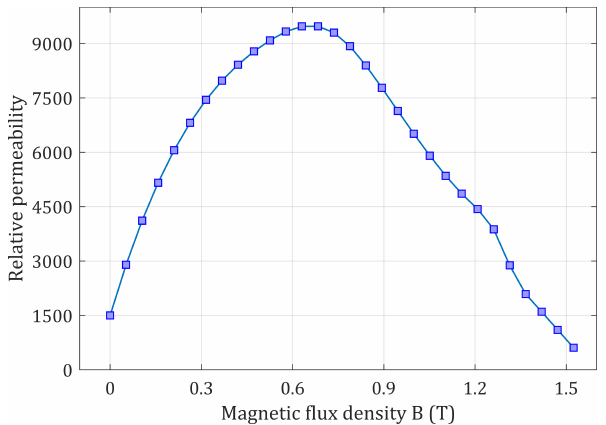
Figure 4. B-H curve of the M400-50A steel type used.